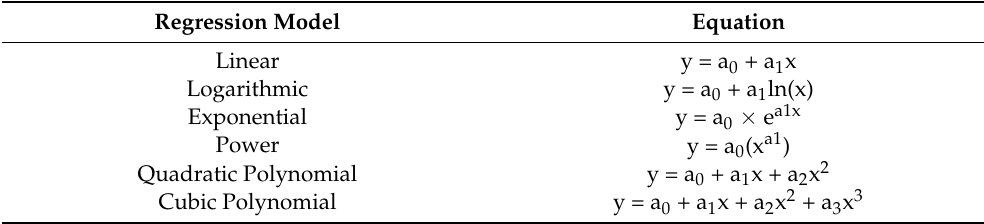
Table 4. Regression models for AOD-PM 2.5 relationship prediction. Regression Model Equation Linear y = a 0 + a 1 x Logarithmic